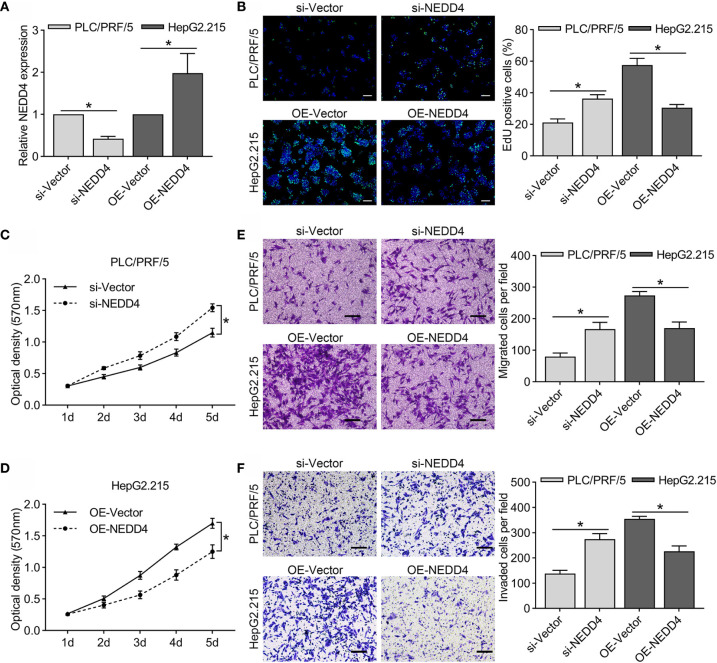
Regulatory effect of NEDD4 in HBV-associated HCC cell lines. (A) NEDD4 mRNA expression in NEDD4 knockdown PLC/PRF/5 cells and NEDD4 overexpression HepG2.215 cells as well as their negative controls. (B) Edu assay was performed to compare the cell growth ability in NEDD4 knockdown PLC/PRF/5 cells and NEDD4 overexpression HepG2.215 cells with their negative controls (Green fluorescence: EdU, Blue fluorescence: Hoechst). (C) Downregulated NEDD4 in PLC/PRF/5 cells promoted proliferation. (D) NEDD4 overexpression in HepG2.215 cells inhibited proliferation. (E) Downregulated NEDD4 promoted migration in PLC/PRF/5 cells, while upregulated NEDD4 inhibited migration in HepG2.215 cells. (F) NEDD4 depletion promoted invasion in PLC/PRF/5 cells, whereas NEDD4 overexpression inhibited invasion in HepG2.215 cells. Data are presented as the mean ± SD. *p < 0.05. (si-NEDD4 represents NEDD4 knockdown PLC/PRF/5 cells, and si-Vector represents the negative control; OE-NEDD4 represents NEDD4 overexpression HepG2.215 cells, and OE-Vector represents the negative control) (n = 3 independently replicated experiments; white scale bars: 100 μm, black scale bars: 50 μm).